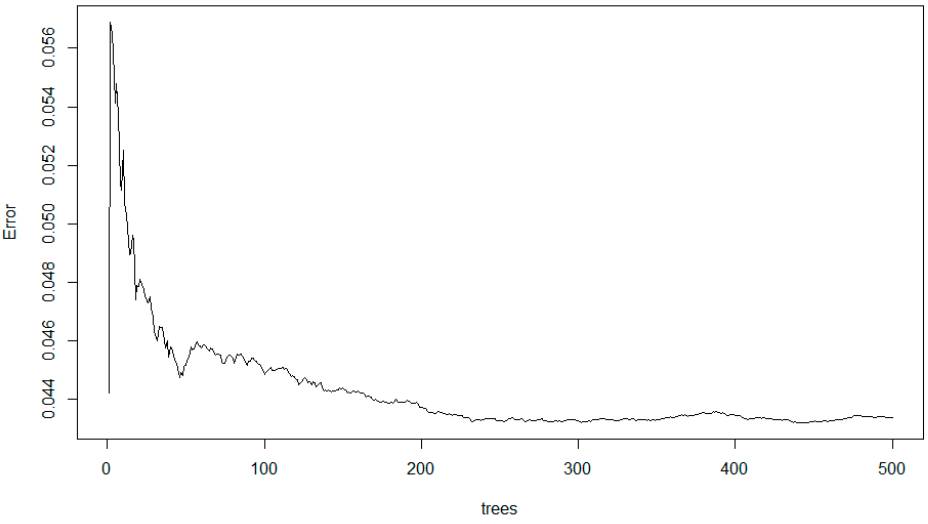
Figure 6. Mean out-of-bag estimate (OOB) over 10.